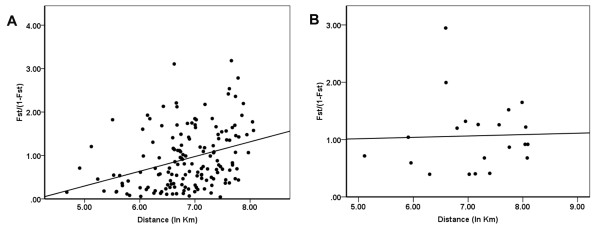
Scatter plots of genetic distance vs. geographical distance for pairwise population comparisons. (A) Red form mite populations (R2 = 0.1129, P = 0.0050; 1000 permutations). (B) Green form mite populations (R2 = 0.01, P = 0.428; 1000 permutations).